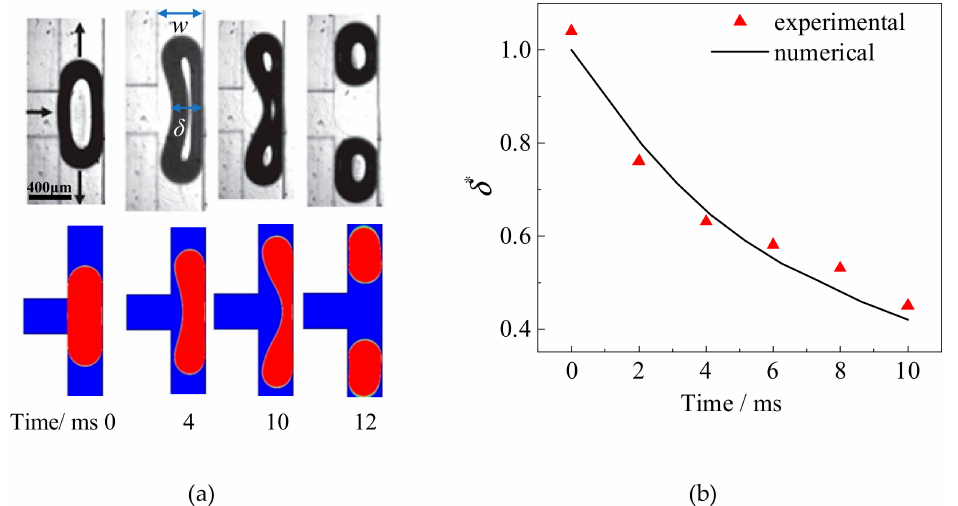
Figure 11. Comparison of experimental and numerical results of bubble breakup in a T-junction. ( a ) Evolution of the bubble shape, ( b ) variation of neck thickness with time